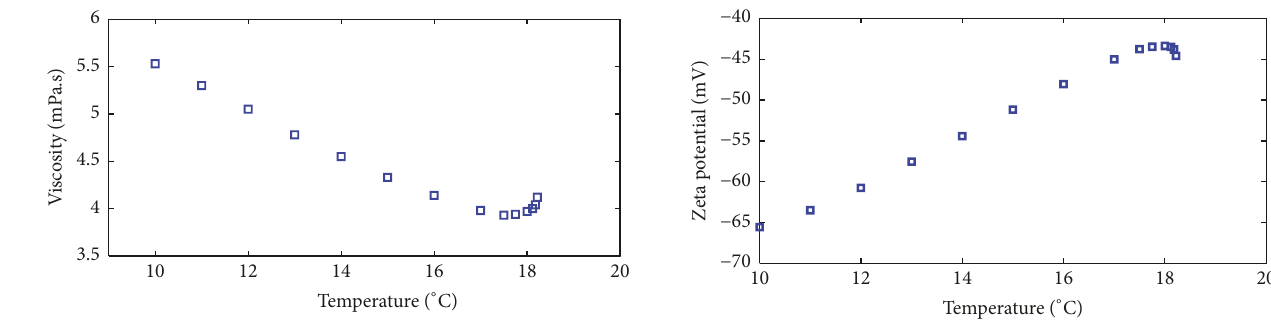
Figure 13: The prediction of the zeta potential as a function of temperature at the critical composition for the well defined binary